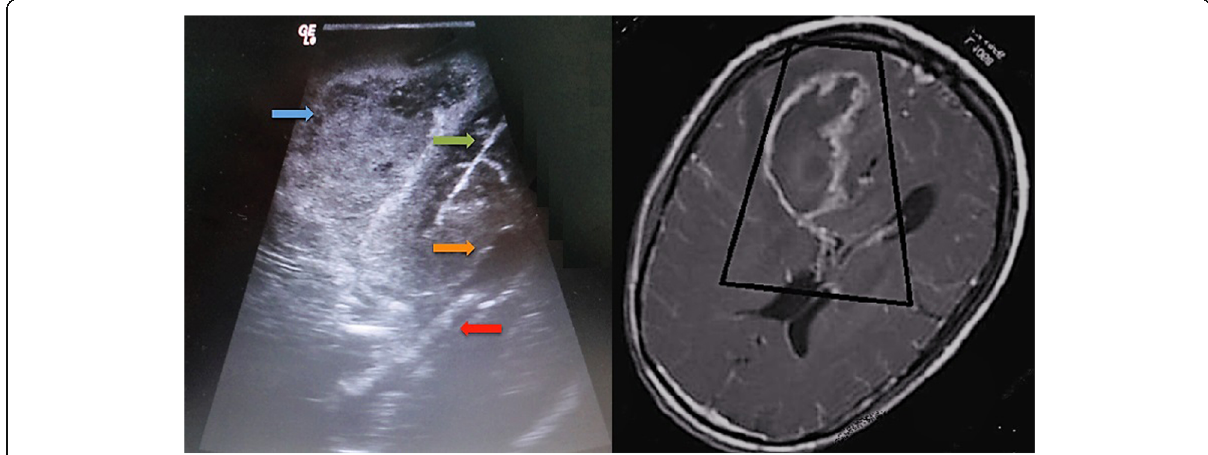
Fig. 3 Illustrative case, ultrasound scan with corresponding MRI slice in the same orientation as the ultrasound transducer. Tumor (blue arrow), interhemispheric fissure (green arrow), contralateral occipital horn (orange arrow), and choroid plexus (red arrow)